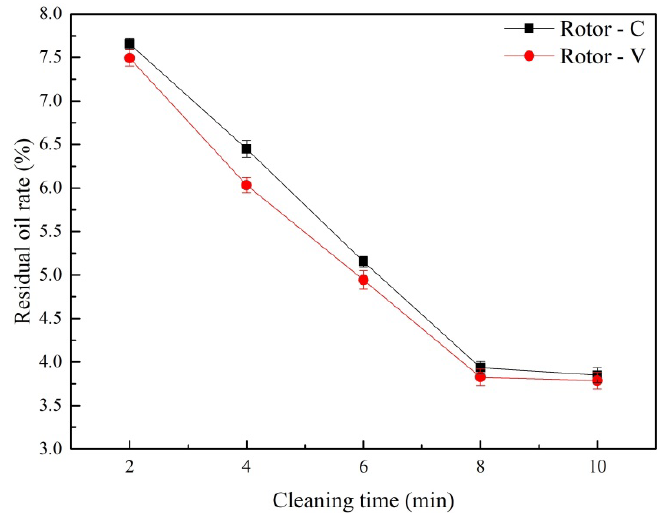
Figure 4. Effects of the cleaning time on the residual oil rate of the oily sludge.